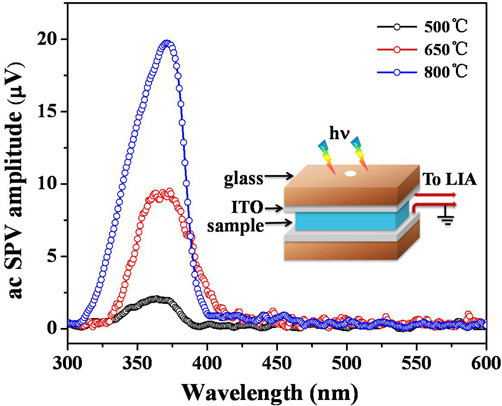
AC SPV amplitude spectra of the ZnMn2O4 nanorods calcined at 500, 650, and 800°C. Inset: schematic of the AC photovoltaic cells.